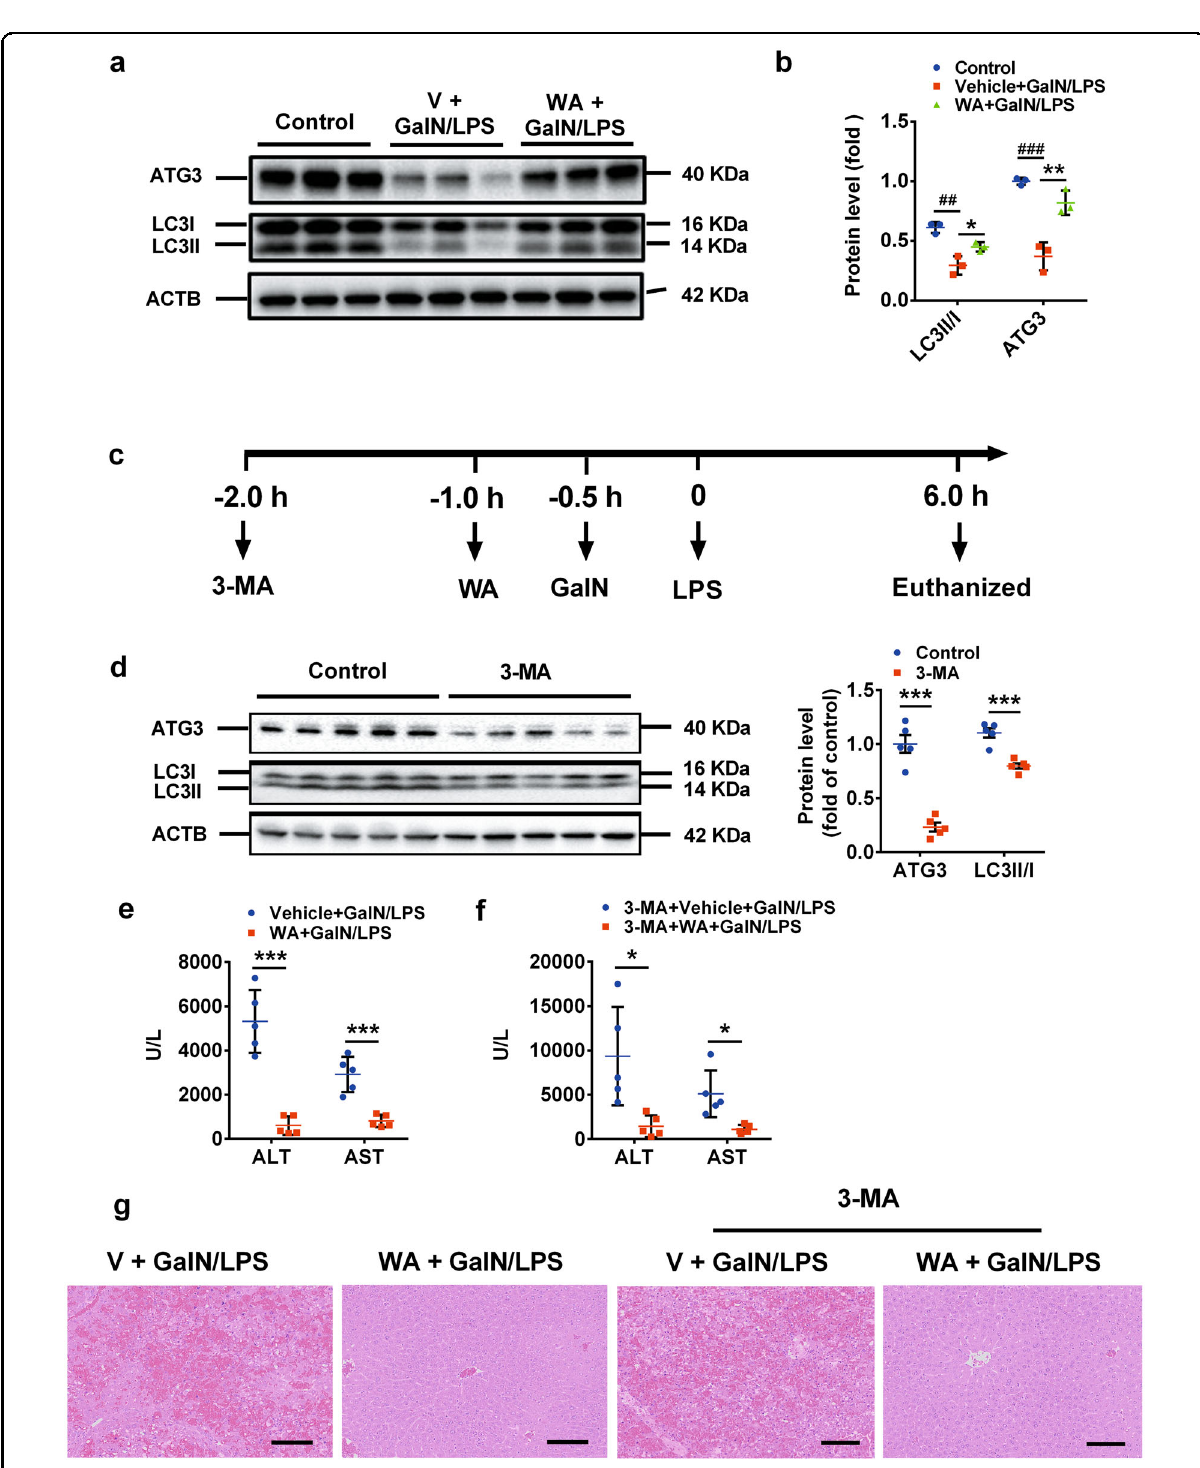
Fig. 4 WA induced hepatic autophagy, while 3-MA failed to abolish the hepatoprotective effect of WA. a Western blot analysis for ATG3, LC3I, and LC3II ( n = 3). b Quantitation analysis of relative protein levels ( n = 3). c Experimental time scheme. d Effect of 3-MA in the expression of ATG3, LC3I, and LC3II. e Serum ALT and AST levels in control saline-pretreated mice treated with or without WA. f Serum ALT levels and AST levels in 3-MA- pretreated mice treated with or without WA. g Representative liver histological H&E staining of control saline-pretreated and 3-MA-pretreated mice treated with or without WA, scale bar 50 μ m. Data are presented as means ± SD ( n = 5 unless otherwise indicated). One-way ANOVA or unpaired two-tailed t test was used for statistical analyses. ## p < 0.01, ### p < 0.005 versus Control; * p < 0.05, ** p < 0.01 and *** p < 0.005 versus V +